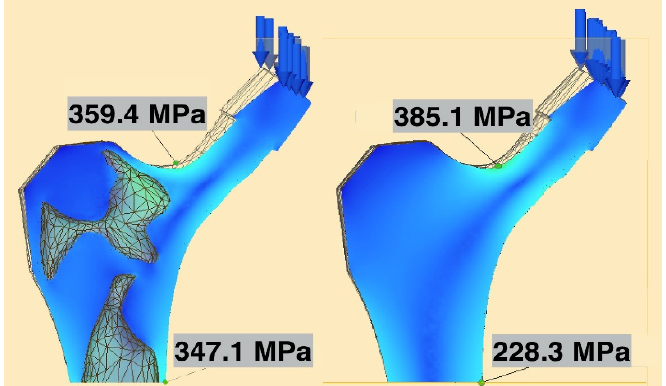
Figure 7. Maximum neck and stem stresses in the selectively hollowed (left) and solid (right) implants. The selectively hollowed implant had marginally lower neck stresses, but higher internal stem stresses compared to its solid equivalent. The image is cropped 10 mm from the distal fixed face.